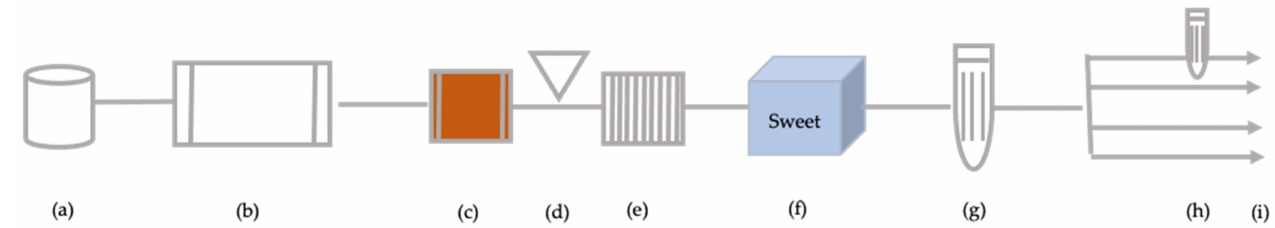
Figure 5. Process diagram of the residence and care institution: ( a ) water source—AQP, ( b ) water storage, ( c ) sand filter, ( d ) chlorination, ( e ) filter, ( f ) water softener, ( g ) UV lamp, ( h ) UV lamp, and ( i ) distribution